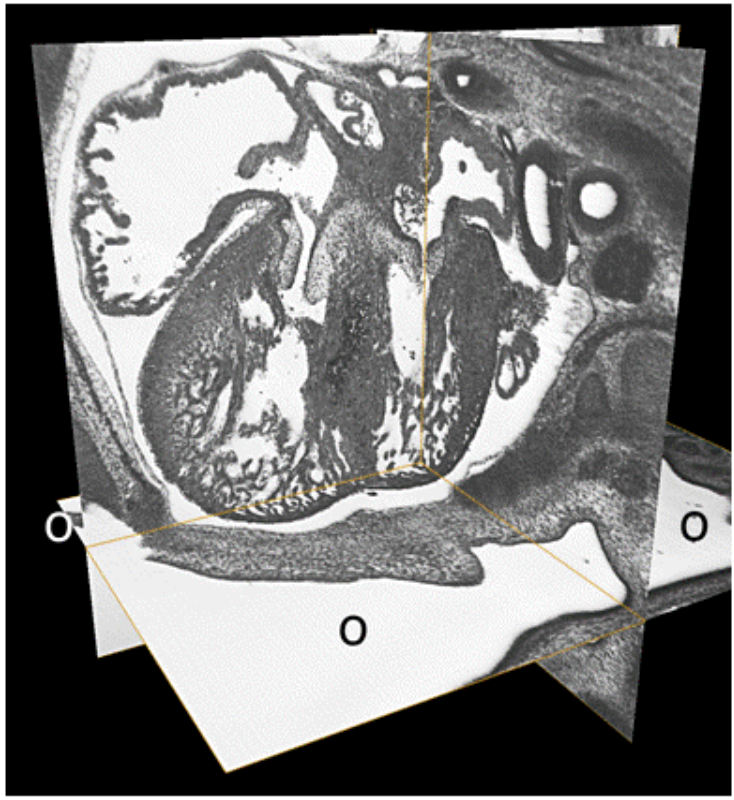
FIGURE 3. Three virtual planes, cutting through HREM volume data, showing the heart of an E14 mouse embryo. Shining through artefacts appear to be sufficiently blocked. o, plane of original HREM images.